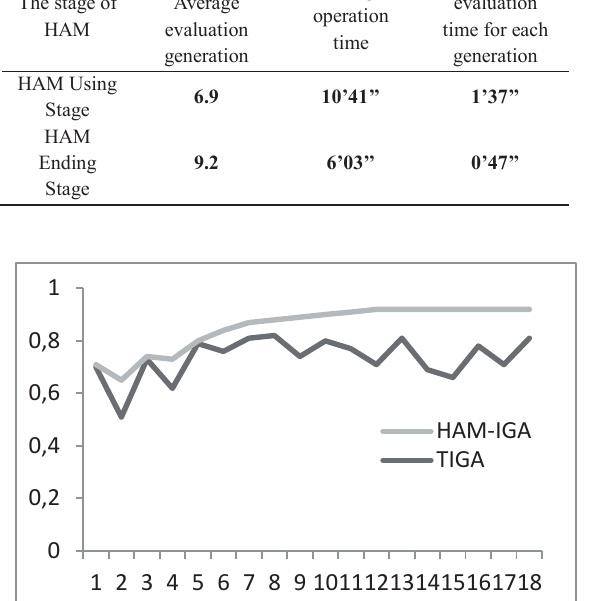
Fig. 8. Comparison of users’ cognitive determination in HAM- IGA and